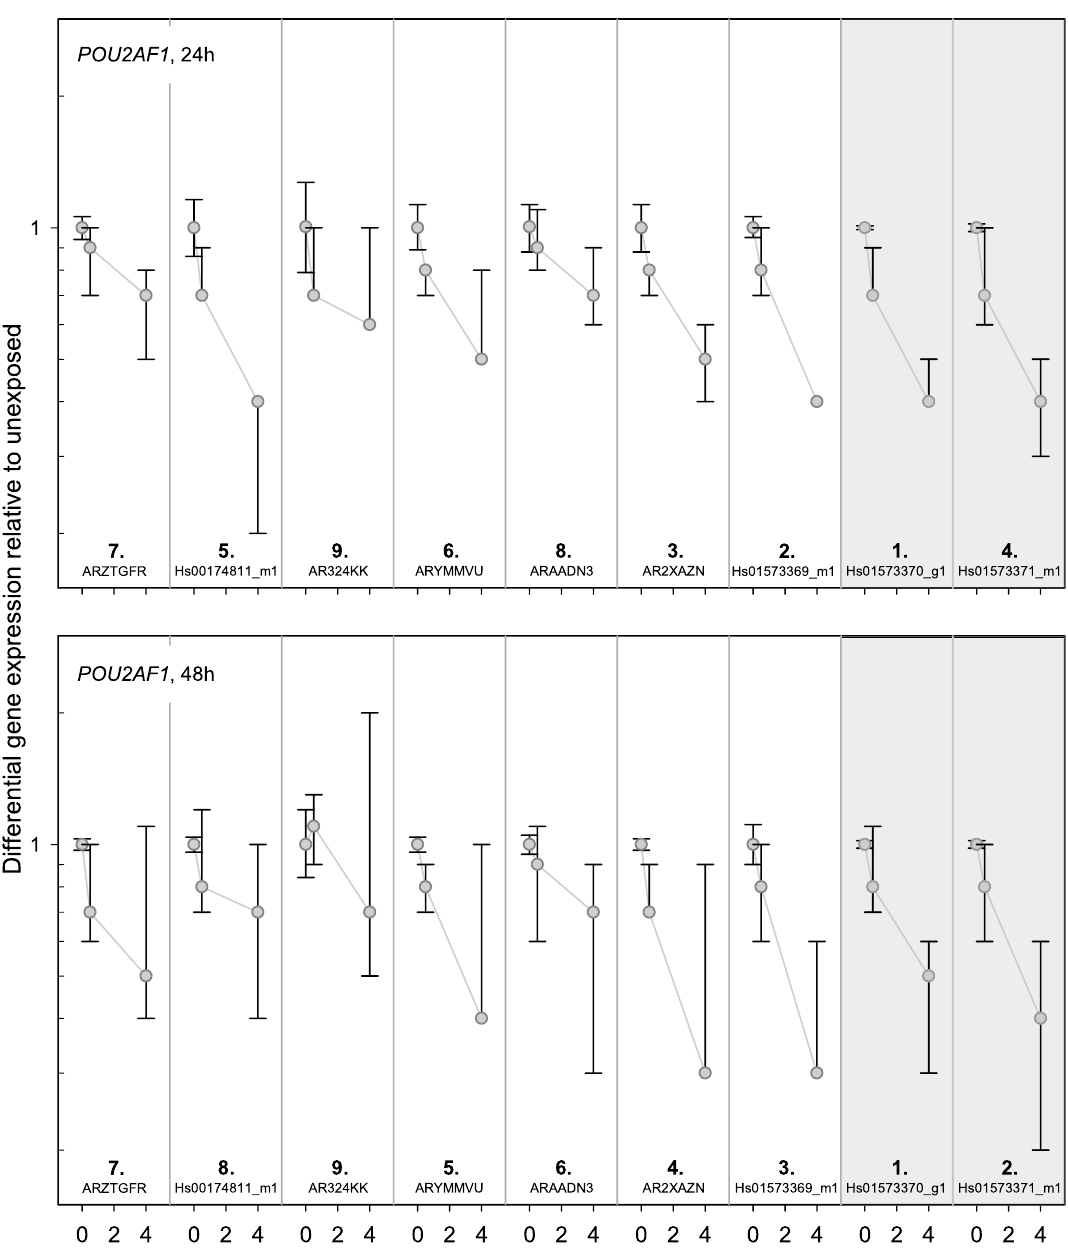
Figure 9. Inter-individual variability of POU2AF1 TaqMan assays. Plotted is the differential gene expression relative to unexposed of POU2AF1 for each assay after 24 h (upper panel) and 48 h (lower panel). The symbol represents the median, and the lower and upper whiskers represent the minimum and maximum fold change, respectively. Additionally symbols are connected with simple straight lines for each TaqMan assay. After summing up the standard deviations of radiation dose, ranks were assigned. 1st rank is the lowest inter- individual variability, 9th rank is the highest. The two assays highlighted in gray are those most suitable for biodosimetry as identified in Fig. 6 using other criteria (baseline, dose dependency, time persistency). Assay labels starting with the two capital letters “AR” can be found after creating an account at Thermo Fisher web site, entering the “Reorder Custom Assays” section with the implemented search function in the “Custom TaqMan Assay Design